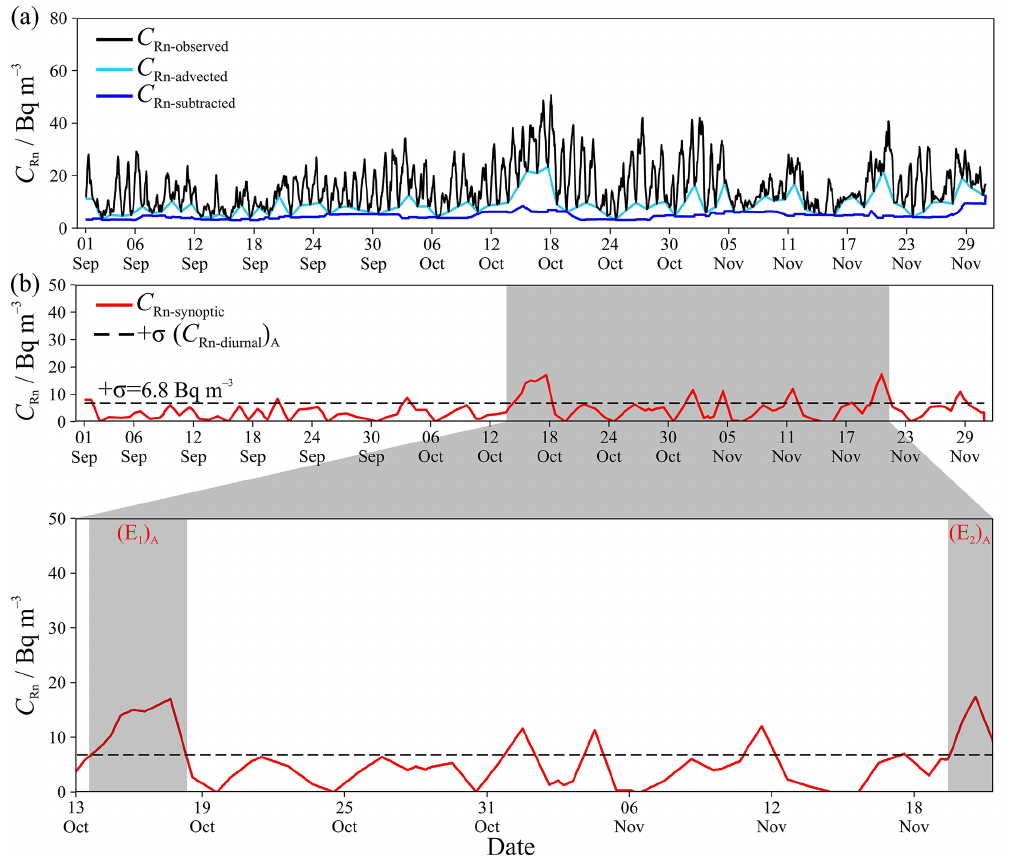
Figure 6. (a) Hourly mean observed radon concentrations, the advected radon contribution with subtracted radon indicated, and (b) isolated synoptic timescale radon contribution in autumn with the standard deviation ( + σ ) of the diurnal contribution indicated. Two persistent temperature inversion events (E i ) A detected by the RBM are shown in the shaded area and enlarged in the breakout panel beneath; see text in Sect. 2.3.1 for